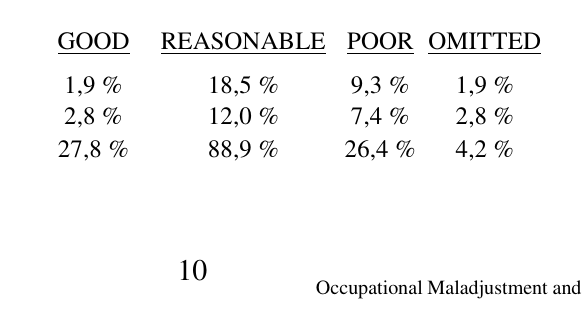
SUCCESS RATES REPORTED FOR VARIOUS